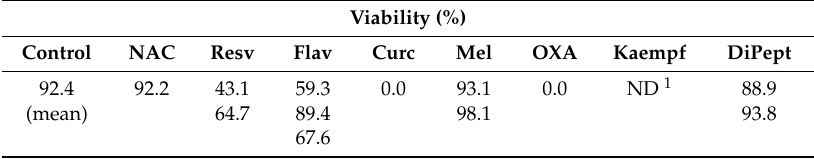
Table 4. NTS viability (%) of NTS after exposure for 72 h to antioxidants alone at 100 µ M, as assessed by staining with